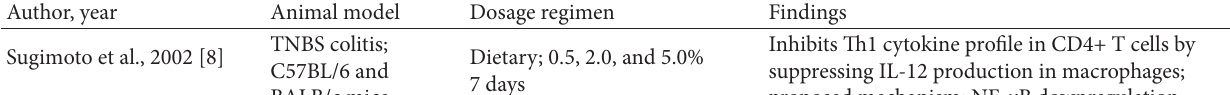
T 1: Curcumin: a list of animal studies demonstrating anti-in�ammatory, chemopreventive, and chemotherapeutic action in gastrointestinal disease (IBD and